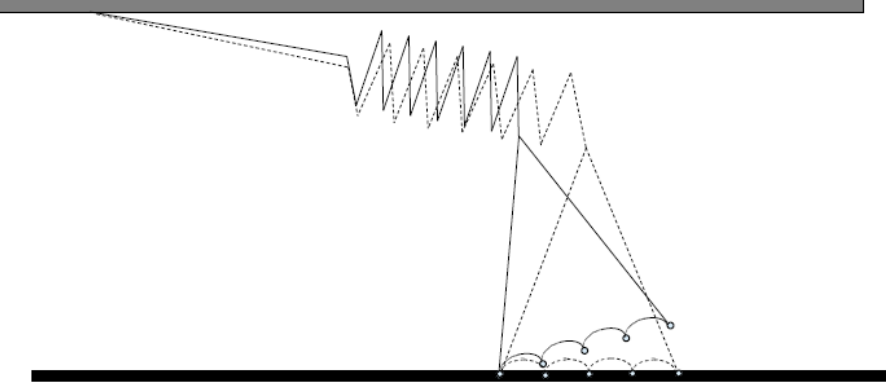
Figure 4. Schematic illustration of length step experiment ( left ) giving rise to tension (force) transients and load-clamp experiment ( right ) giving rise to velocity transients of muscle cells followed by steady-state shortening at constant velocity. In the length-step experiment length is controlled and the resulting tension transient includes a drop of tension from the isometric value, T 0 down to the extreme tension level at the end of the length step, T 1 . This is followed by a subsequent rapid recovery to the intermediate tension level T 2 (see further text). In the load-clamp experiment, load (force) is controlled, and the resulting length changes are recorded, e.g., the initial elastic response (amplitude L 1 ) when force drops and the subsequent rapid phase of shortening (phase 2; ending at length L 2 ) before slower shortening at a steady-state rate.